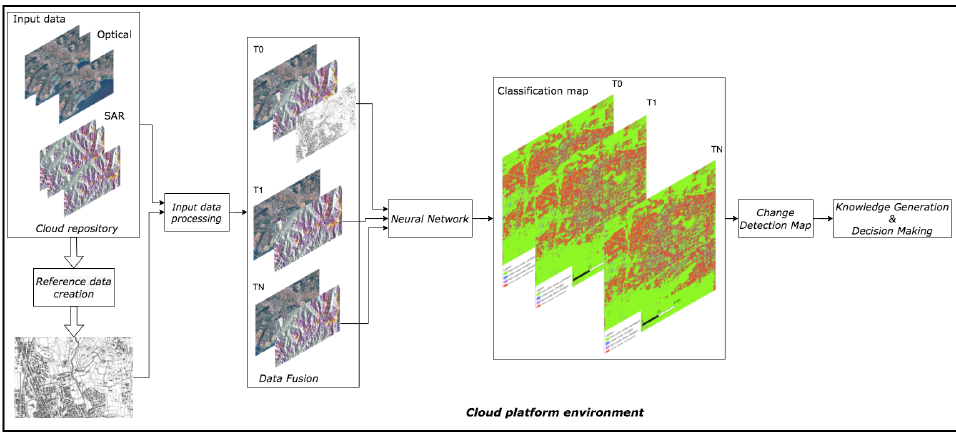
Figure 2. Workflow of the proposed decision aid